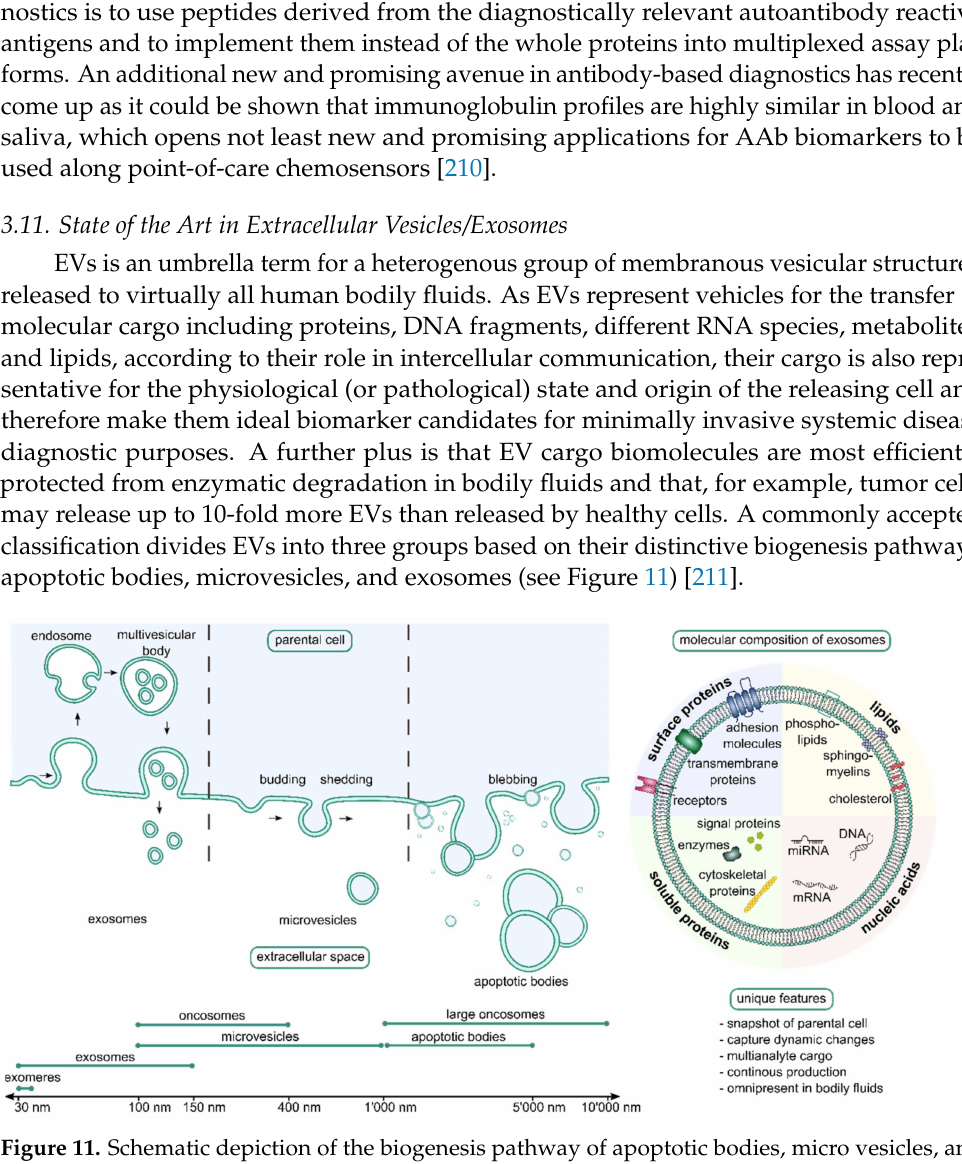
Figure 11. Schematic depiction of the biogenesis pathway of apoptotic bodies, micro vesicles, and exosomes and the respective characteristic size ranges reported for these vesicle types (left side). Molecules which can be typically detected in exosomes are shown (right side). Reprinted with permission from [211]. 2021, Adv. Drug Deliv. Rev. is open access journal where copyright stays with authors. C